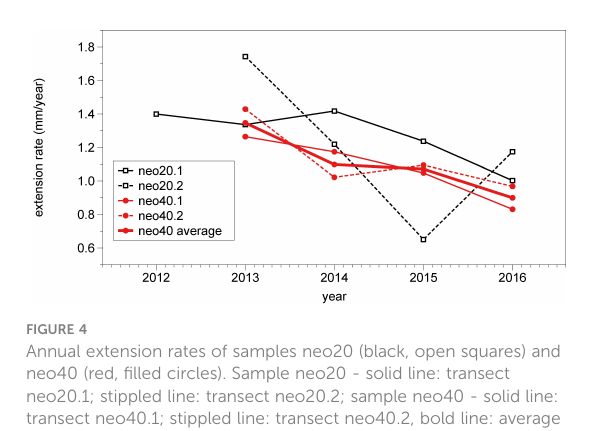
FIGURE 4 Annual extension rates of samples neo20 (black, open squares) and neo40 (red, fi lled circles). Sample neo20 - solid line: transect neo20.1; stippled line: transect neo20.2; sample neo40 - solid line: transect neo40.1; stippled line: transect neo40.2, bold line: average of neo40 transects.